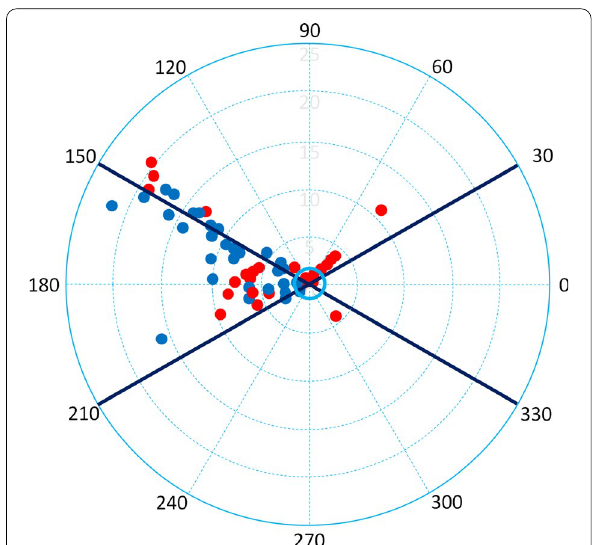
Fig. 3 Polar plot analysis during the EEXPO test. Polar plot analysis for relative changes in CI Starling‑24.4 (red dots) and CI Starling‑8.1 (blue dots) compared to the changes in CI pulse during the EEXPO test. The radial limits of the agreement have been reported. The central exclusion zone (continuous light blue circle) removes data points, where the changes in cardiac index are small (less than 1.5%). The polar concordance at 30 degrees is 83% for Starling‑8.1.1 and 71% for Starling‑24.4. CI pulse : cardiac index measured by the pulse contour analysis method; CI Starling‑24.4 : cardiac index measured by the commercial version of the Starling device (averaging time 24 s, refresh time 4 s); CI Starling‑8.1 : cardiac index derived through raw data analysis of the Starling device (averaging time 8 s, refresh